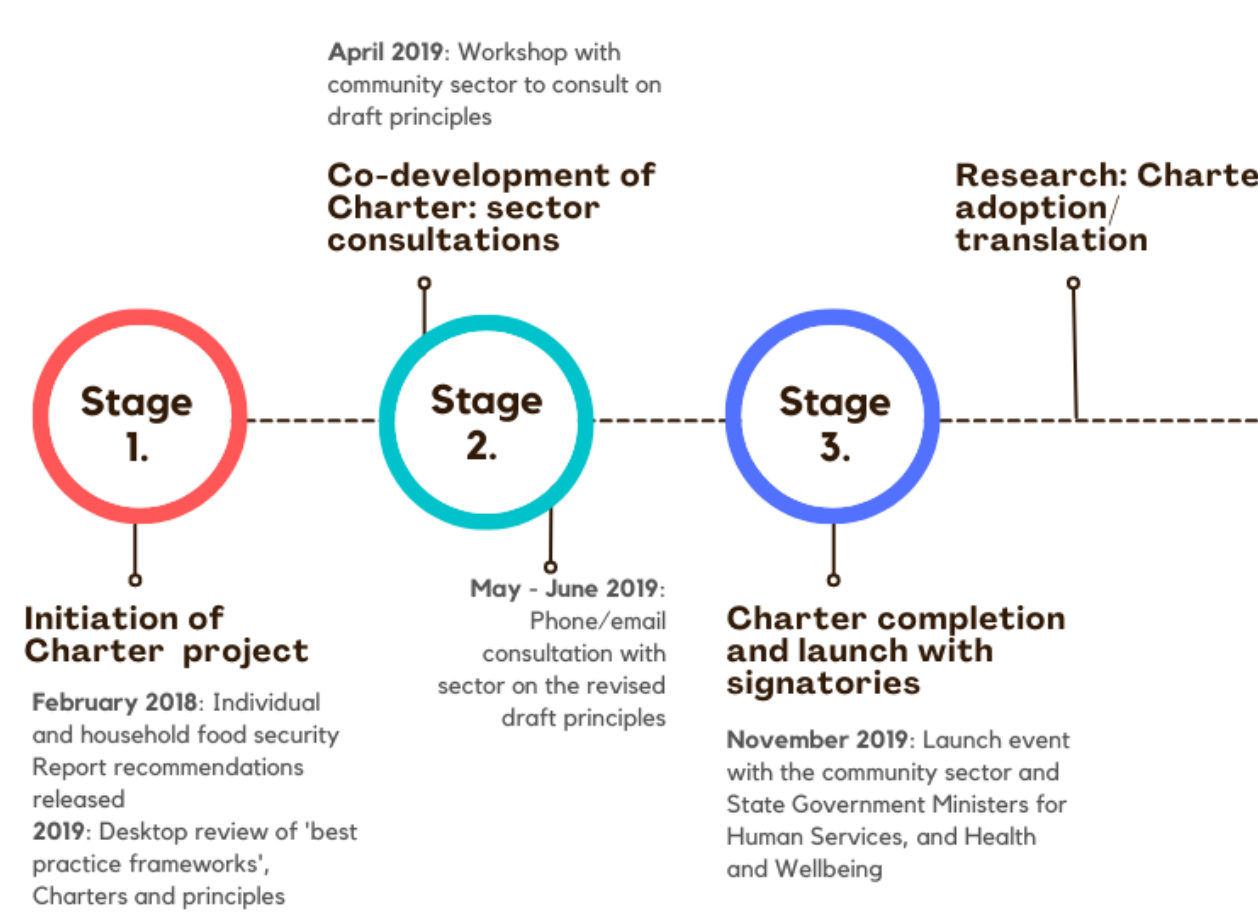
Figure 2. Process of the SA Food Relief Charter co-development.